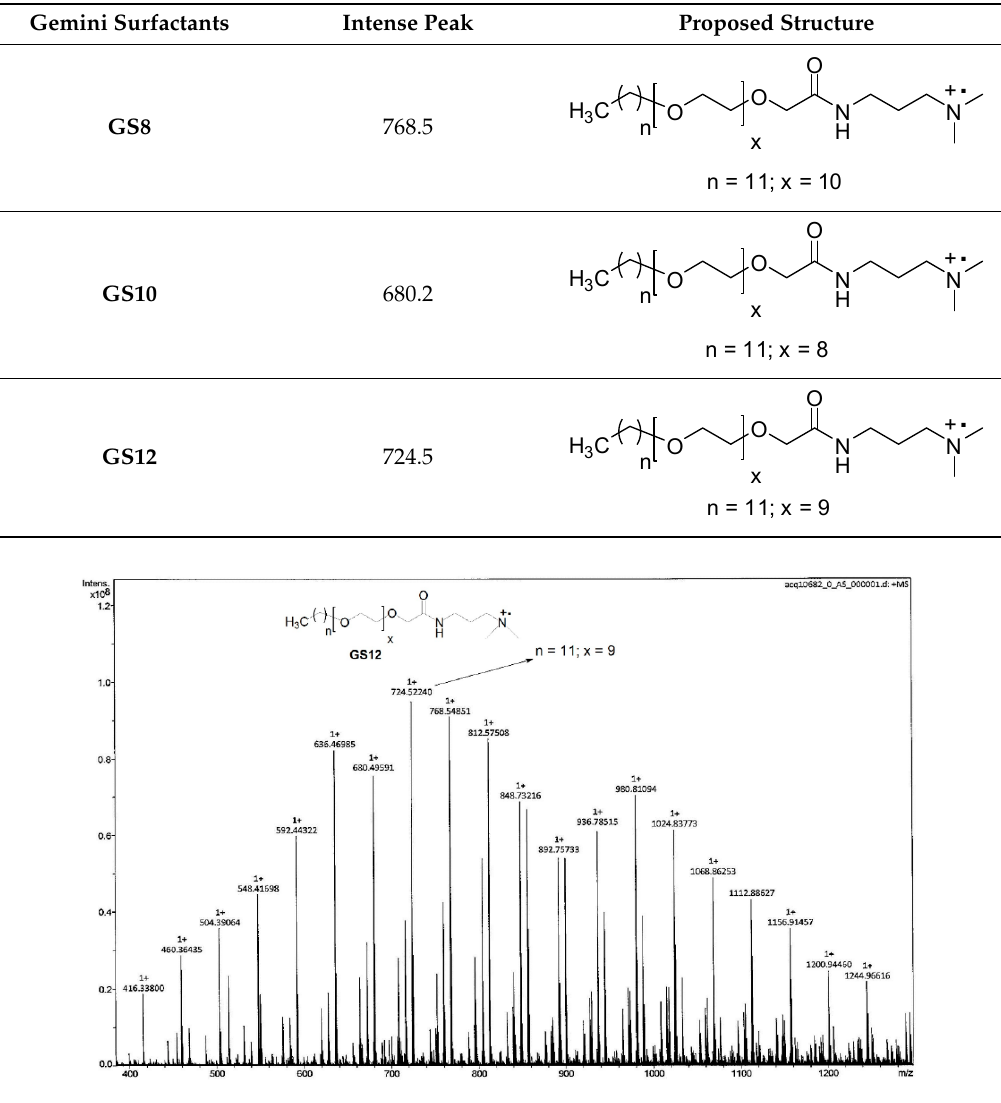
Table 4. MALDI-TOF MS analysis of quaternary ammonium gemini surfactants (GS8, GS10, and GS12). Gemini Surfactants